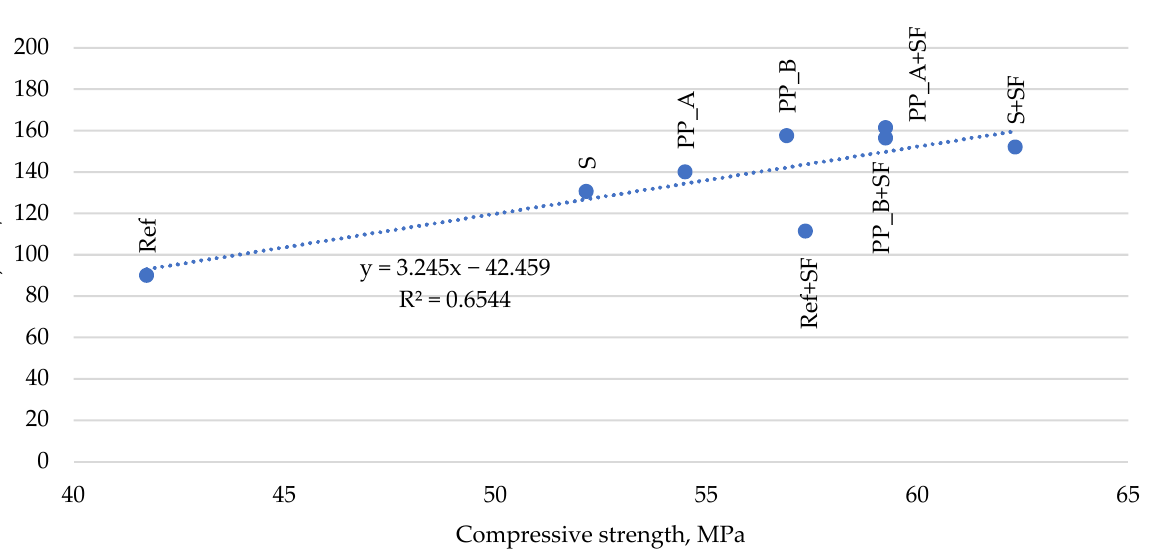
Figure 8. Cost of fresh concrete in terms of flexural strength.